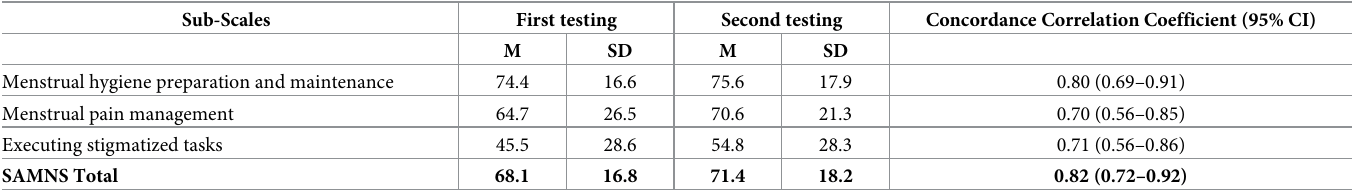
Table 6. Temporal stability of Self-Efficacy in Addressing Menstrual Needs Scale (SAMNS) scores after mean interval of 15 days (n = 42). Sub-Scales